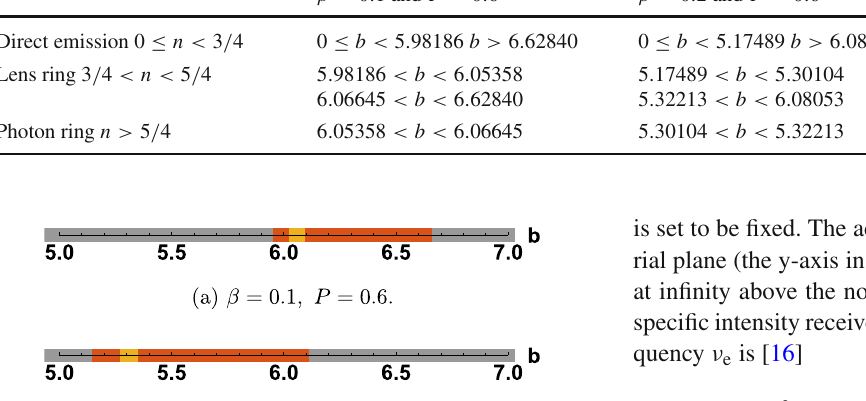
Table 4 The ranges of direct emission, lens ring, and photon ring with respect to the impact parameter b in the left panels for different parameters β and P with fixed M = 1 β = 0 . 1 and P = 0 . 6 β = 0 . 2 and P = 0 . 6